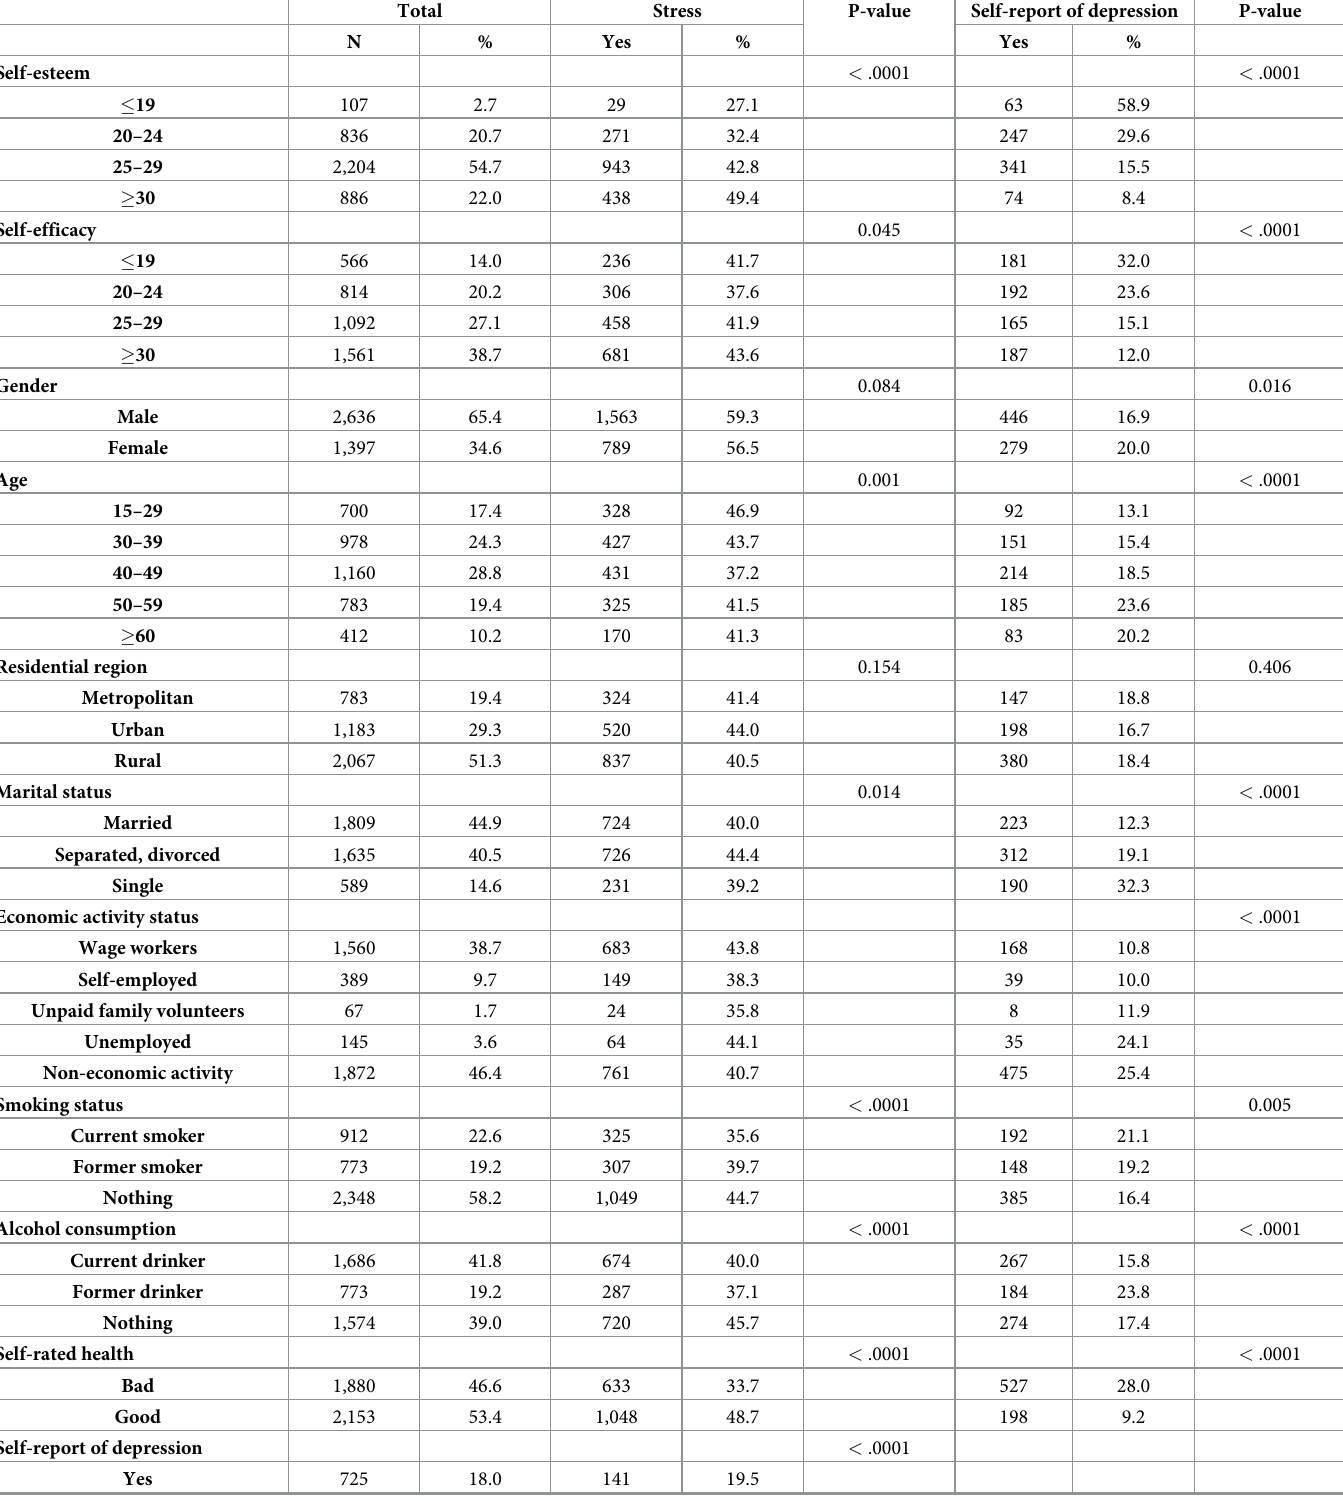
Table 1. General characteristics of subjects included for